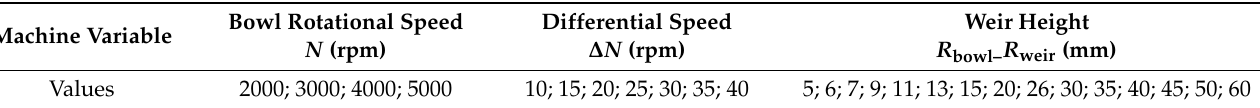
Table 2. Operative variables of the SBC tested in the present work.